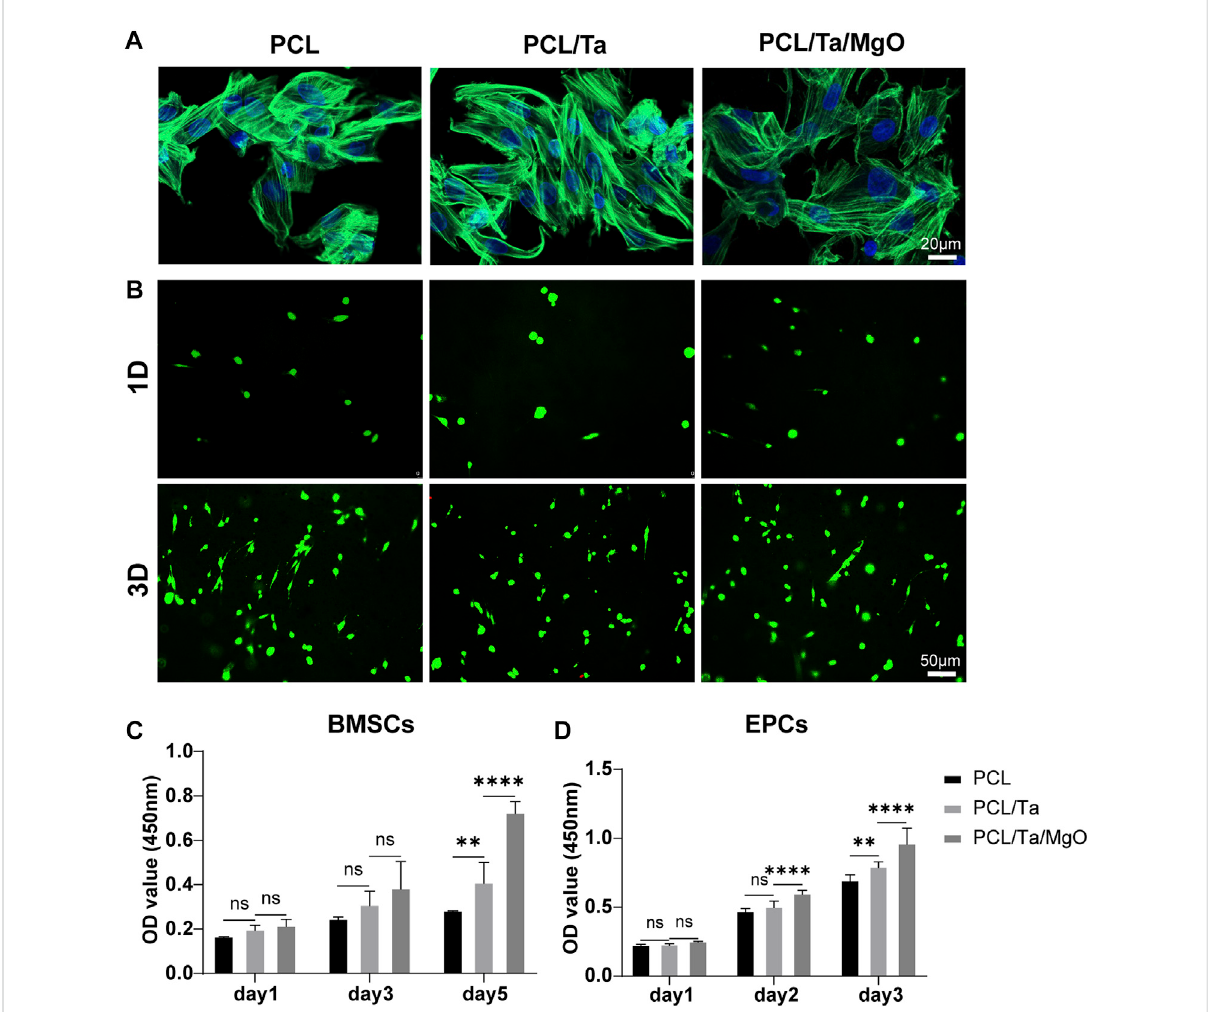
FIGURE 3 CytocompatibilityofPCLanddifferentnanoparticle-dopedmembranes. (A) BMSCmorphologyondifferentmembranesonday1; (B) Live/dead stainingofBMSCsculturedonthemembranesafter1 dand3d;CCK-8assayof (C) BMSCproliferationondays1,3,and5and (D) EPCproliferationon days 1, 2, and 3. ( n = 6) (* p < 0.05, ** p < 0.01, *** p < 0.001, and **** p <